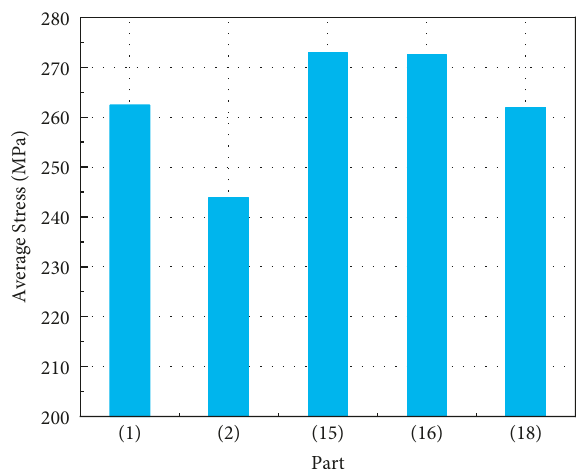
Figure 32: Average stress of each shackle.